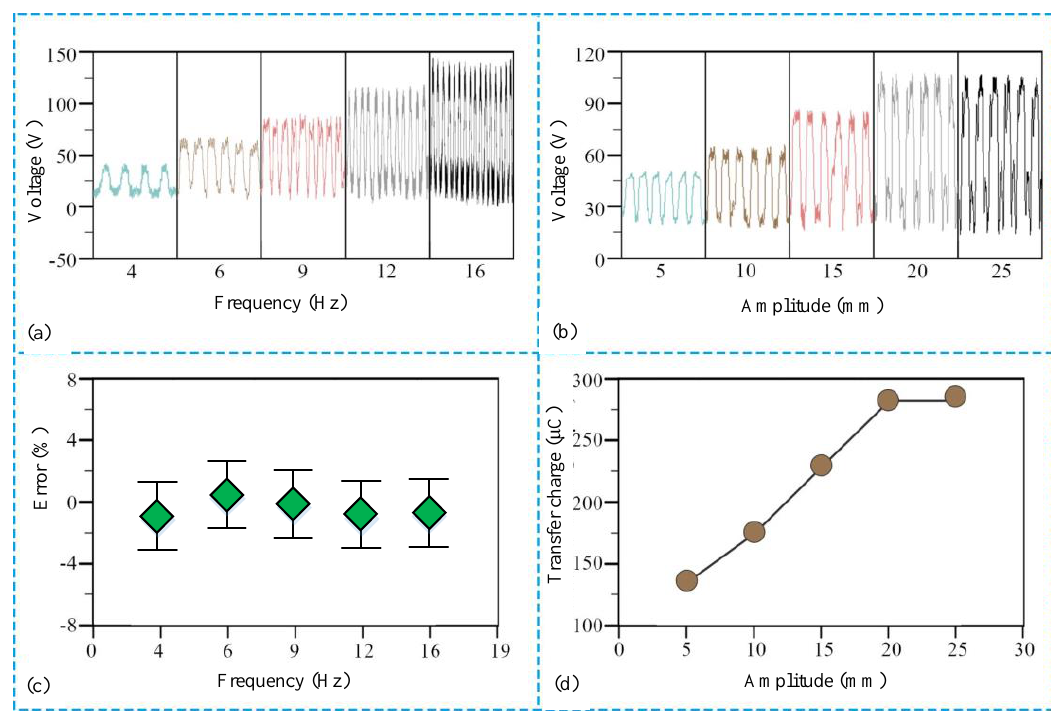
Figure 3. Sensing performance study of the RSV − TENG. ( a ) Frequency−sensing performance; ( b ) amplitude−sensing performance; ( c ) vibration frequency measurement error; and ( d ) vibration amplitude measurement error.